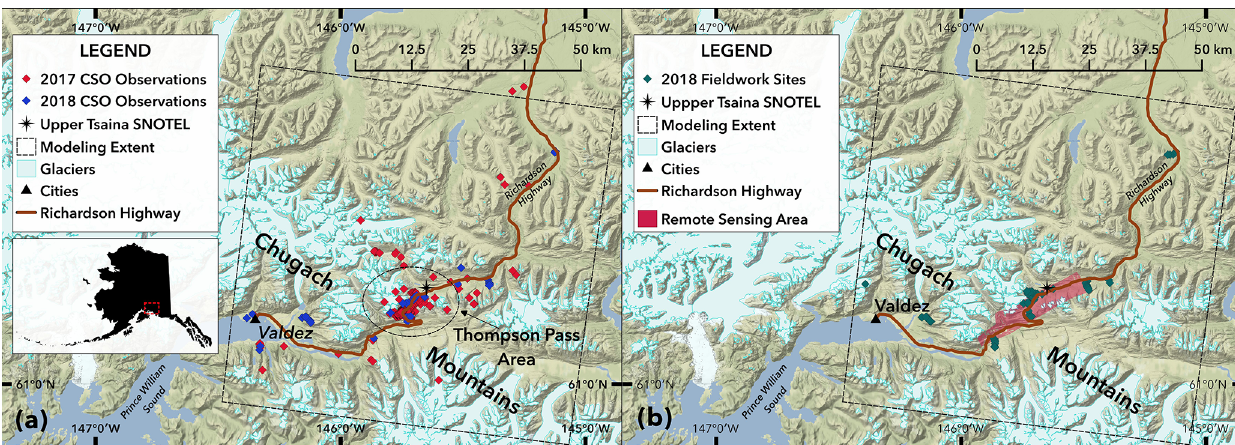
Figure 1. Study area map and fieldwork sites. (a) The study area maps showing the CSO measurements, the modeling spatial extent, and the Thompson Pass region of the Chugach Mountains. (b) The 2018 fieldwork includes 72 sites with co-located snow water equivalent and snow depth measurements. The remote sensing data sets from 2017 and 2018 are overlain on the map, along with the location of the Upper Tsaina SNOTEL station.